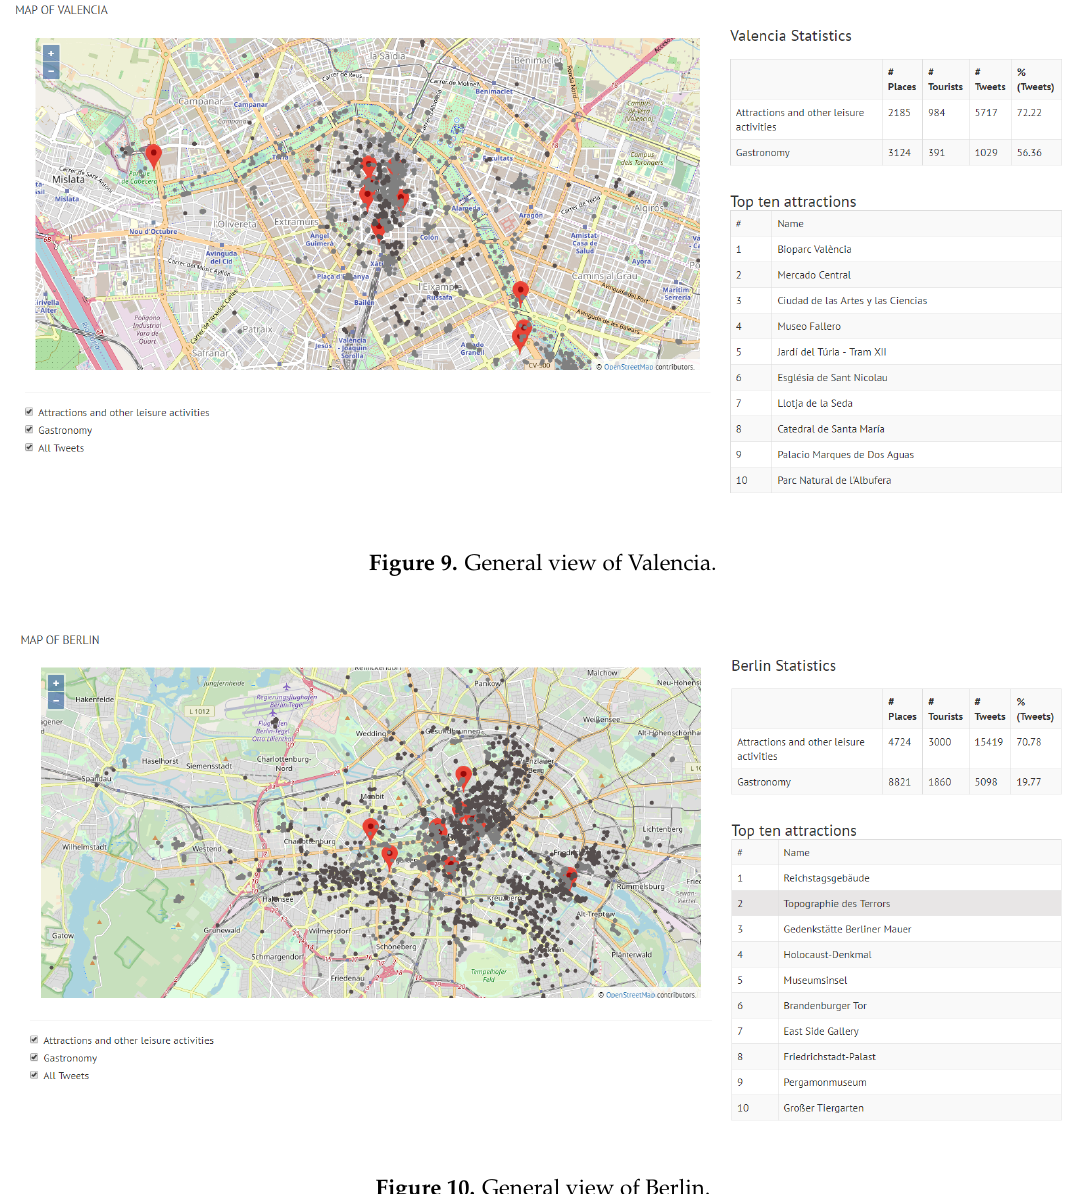
Figure 10. General view of